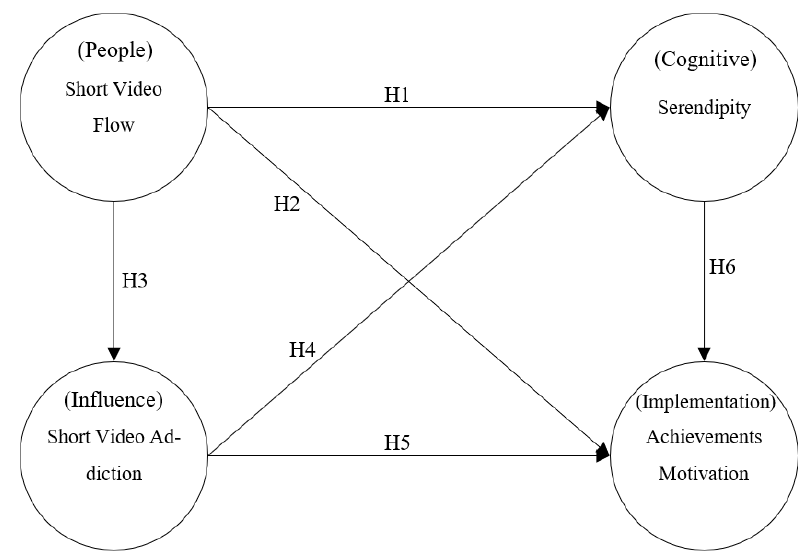
Figure 1. Research Model.